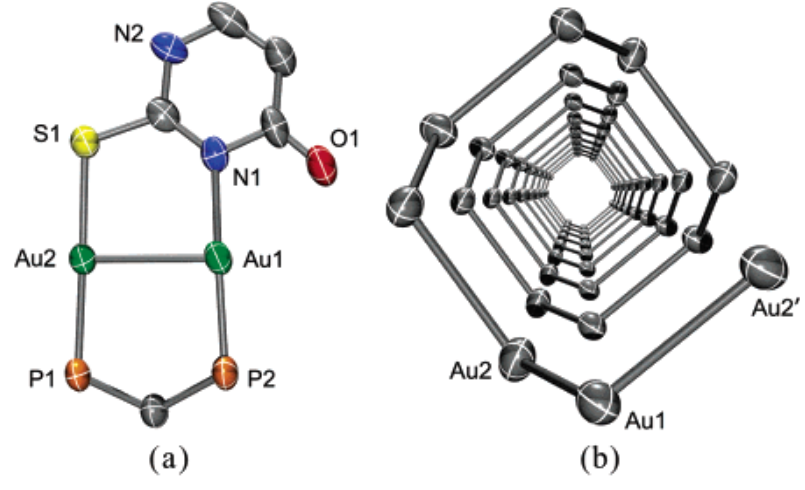
Figure 2. (a) View of cationic Au(I) thiouracilate containing dppm (phenyl rings omitted) and (b) helical arrangement of Au(I) ions with ligands omitted for clarity. Reproduced with permission from